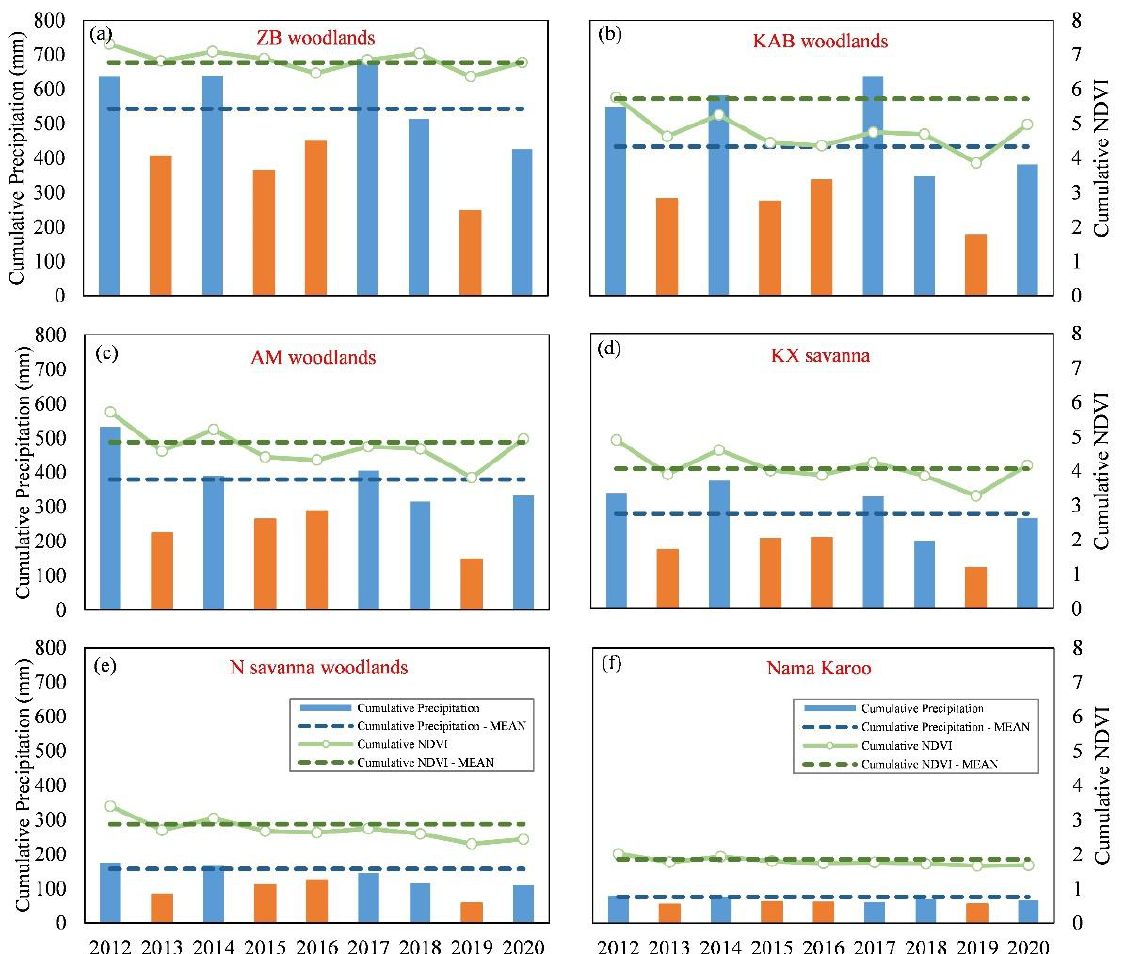
Figure 8. Comparative analysis of the three drought events before, during, and after drought in different ecological zones in Namibia: ( a ) ZB Woodlands; ( b ) KAB Woodlands; ( c ) AM Woodlands; ( d ) KX Savanna; ( e ) N Savanna Woodlands; and ( f ) Nama